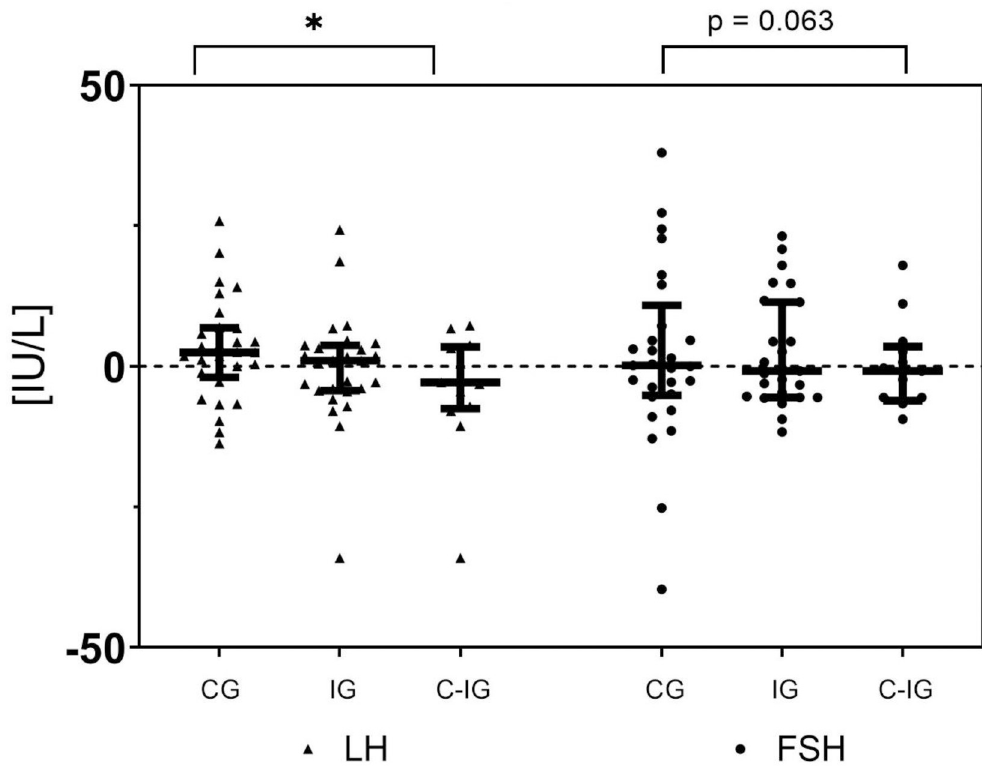
Fig 3. Scatter dot plot of the absolute levels of change in LH and FSH between the baseline and week-15 visit. Separated plots are presented for each per-protocol defined group; control group (CG), intervention group (IG) and compliant intervention group (C-IG). The absolute change in LH over 15 weeks differed significantly between the compliant intervention group and the control group. A similar albeit non-significant trend was observed for FSH. � = p <